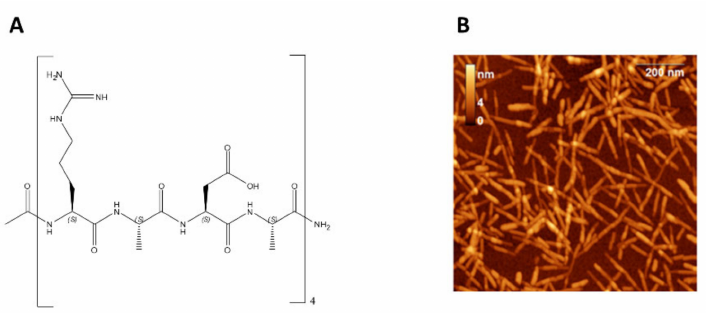
Figure 5. ( A ) Chemical structure of RADA16. ( B ) AFM images of RADA16 fibrils. Figure reproduced from